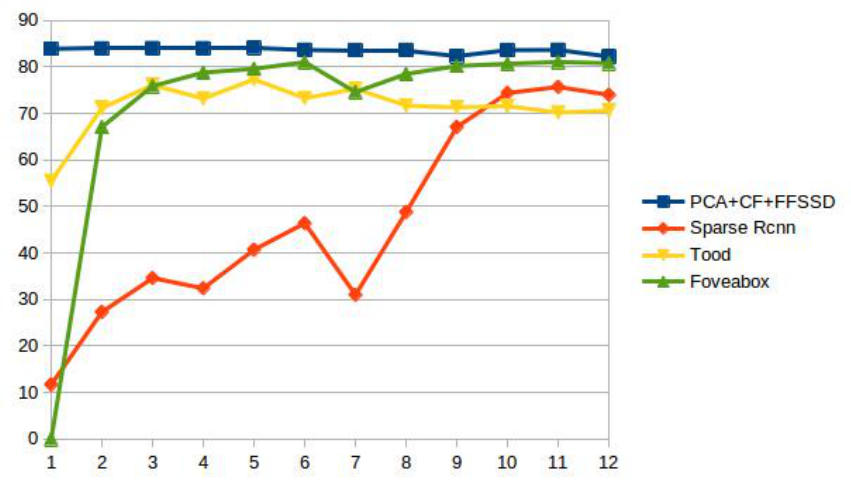
Figure 13. Comparison of mAP for ten training epochs. Because of the pre-training weight, the mAP of the PCA+CF+FFSSD is relatively high; FoveaBox is second (Figure 14).